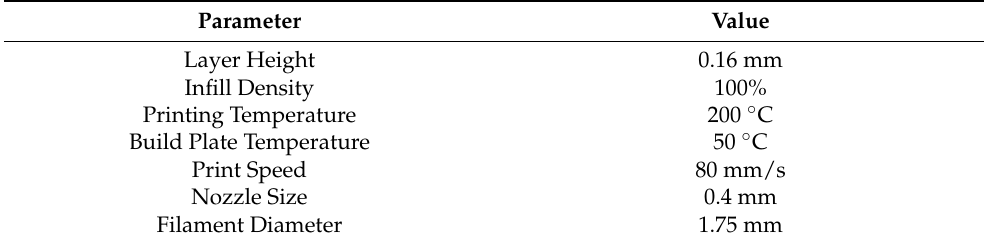
Table 1. Printing parameters set by the slicing